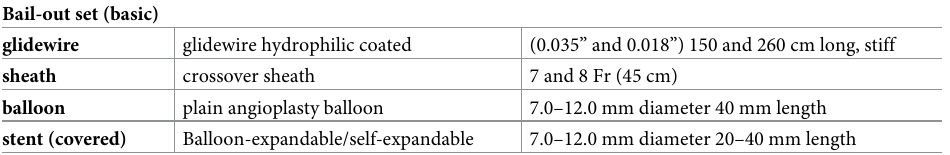
Table 3. Basic bail-out set for treating iliofemoral access site complications. Bail-out set